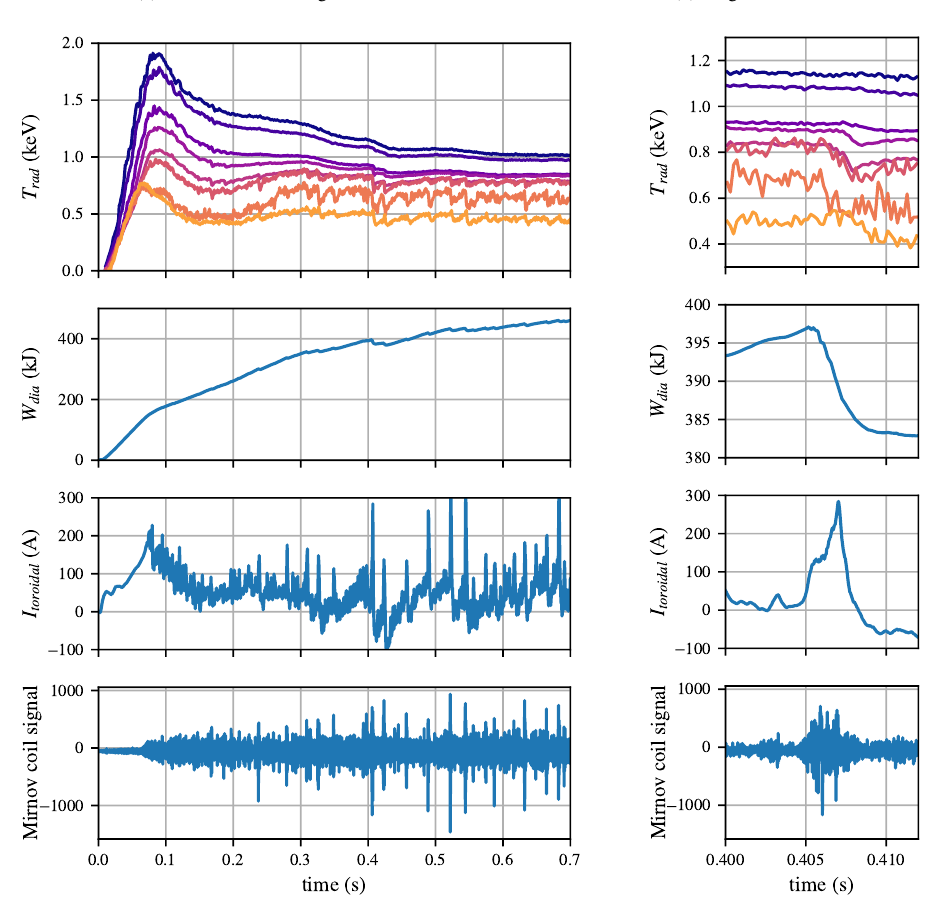
Figure 1: (a) Time traces of the ECE radiation temperature, T rad , at high field side (HFS) frequencies, the diamagnetic energy, W dia , the toroidal current, I toroidal , and the magnetic fluctuations measured by Mirnov coils are shown for the plasma discharge #20180927.026 where the 5 / 5 island chain was moved inside the last closed flux surface. (b) Zoomed in time traces of (a) at 0.4 s showing the temporal evolution of di ff erent parameter during a single ELM-like